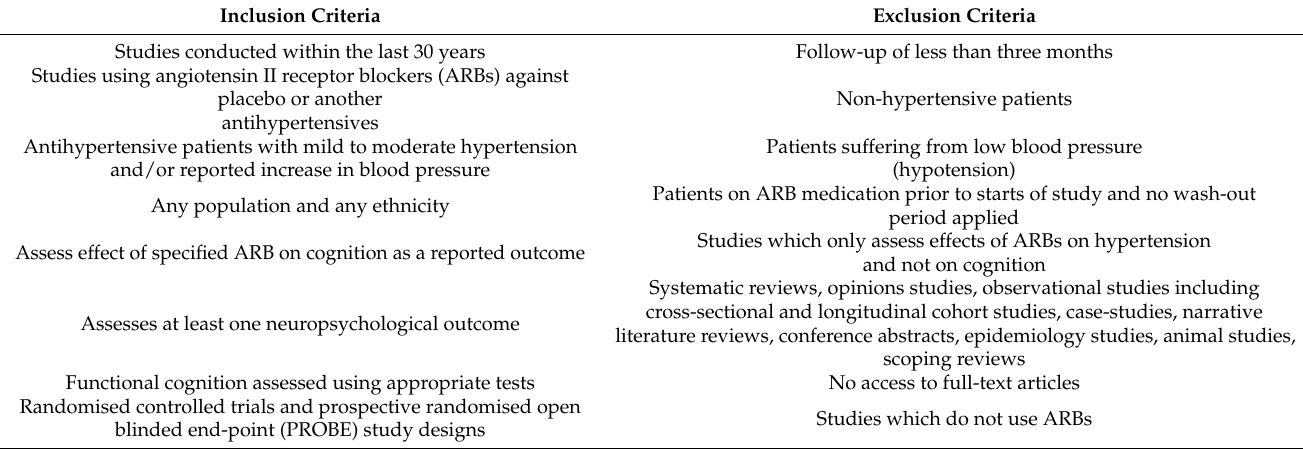
Table 4. Inclusion and exclusion criteria used in the screening process to find relevant references required for the systematic